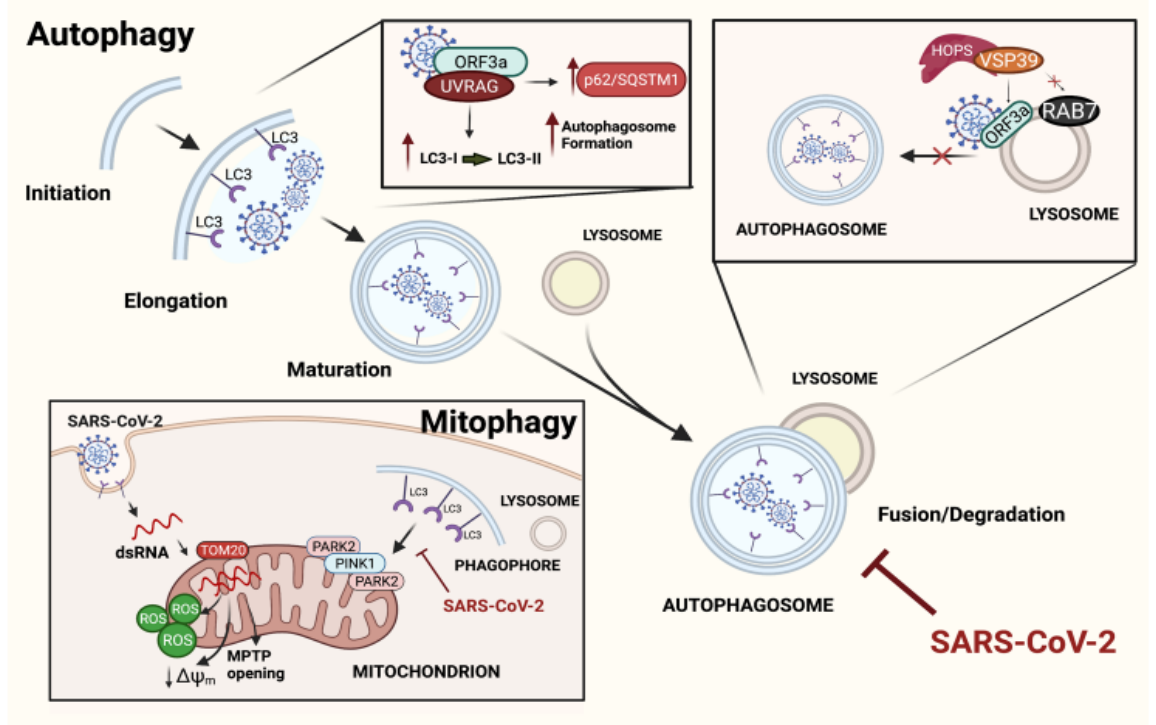
Figure 2. Mechanisms of the SARS-CoV-2 evasion of autophagic pathways. Illustration depicting principal mechanisms developed by SARS-CoV-2 in order to use autophagy pathways for its own benefits. Diagonally, the main steps of the autophagic process are represented. The viral ORF3a interacts with UVRAG at high affinity, undermining the link UVRAG-BECN1 and promoting an accumulation of autophagosomes, which never fuse with lysosomes. Another mechanism through which ORF3a inhibits the autophagosome–lysosome fusion is by binding VPS39 of the HOPS complex, thus preventing the RAB7–VSP39 interaction. Even mitophagy has been reported to be affected by SARS-CoV-2. Indeed, once inside the cell, the viral dsRNA enters the mitochondria, thus leading to mitochondrial dysfunctions that promote PINK1/PARK2-dependent mitophagy. However, the process never ends as the virus blocks the incorporation of the mitochondria into autophagosomes, improving viral replication. Created with